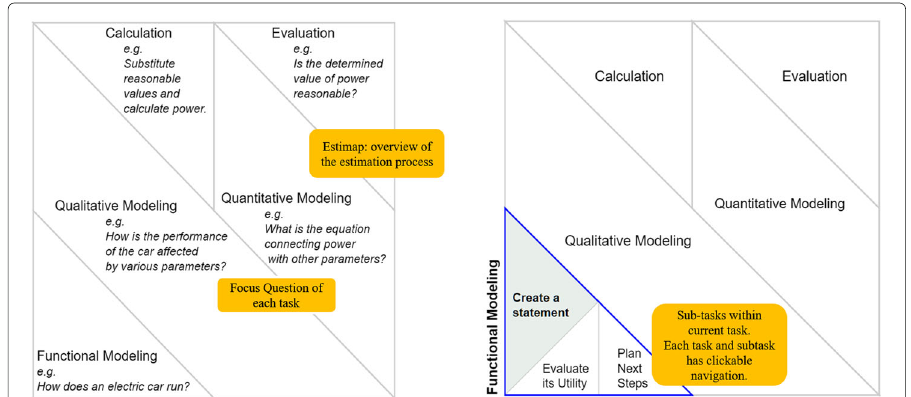
Fig. 4 Process management feature “Estimap” of MEttLE. This figure shows the top level and detailed views of the “Estimap” feature of MEttLE